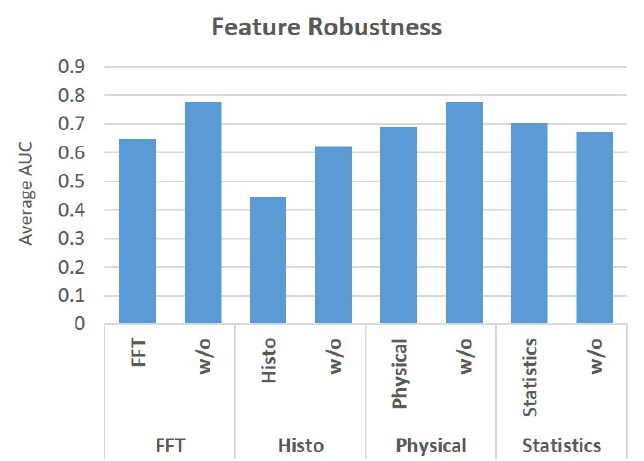
Figure 6. Average AUC results of the AdaBoost and Gradient Boosting classifiers based on specific types of features and without